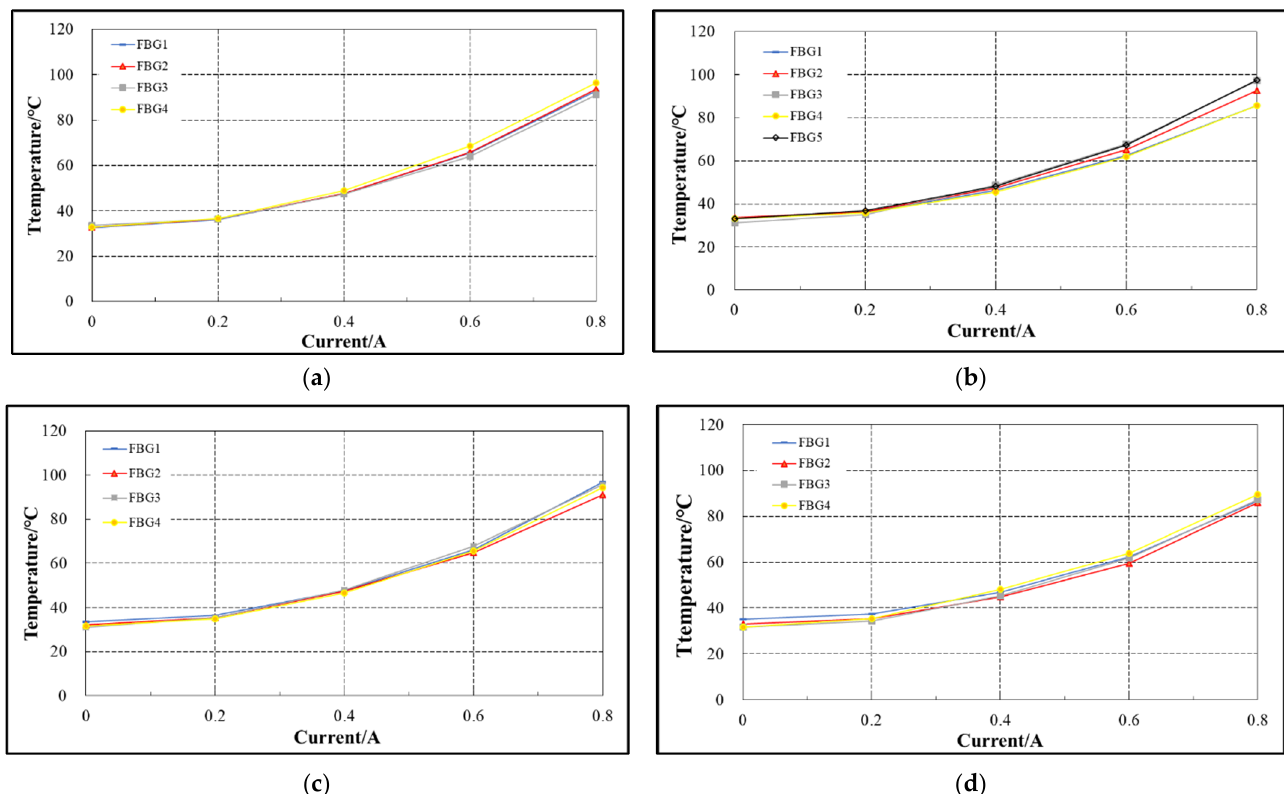
Figure 17. Arrangement of FBG sensor in iron core.